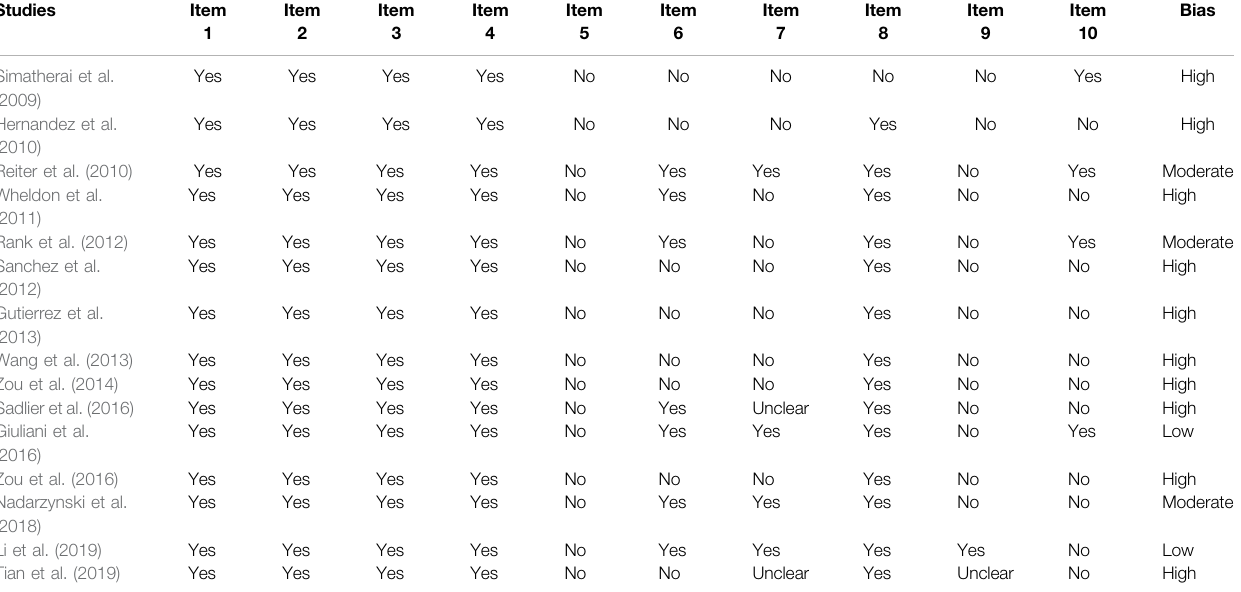
TABLE 1 | Quality assessment of included